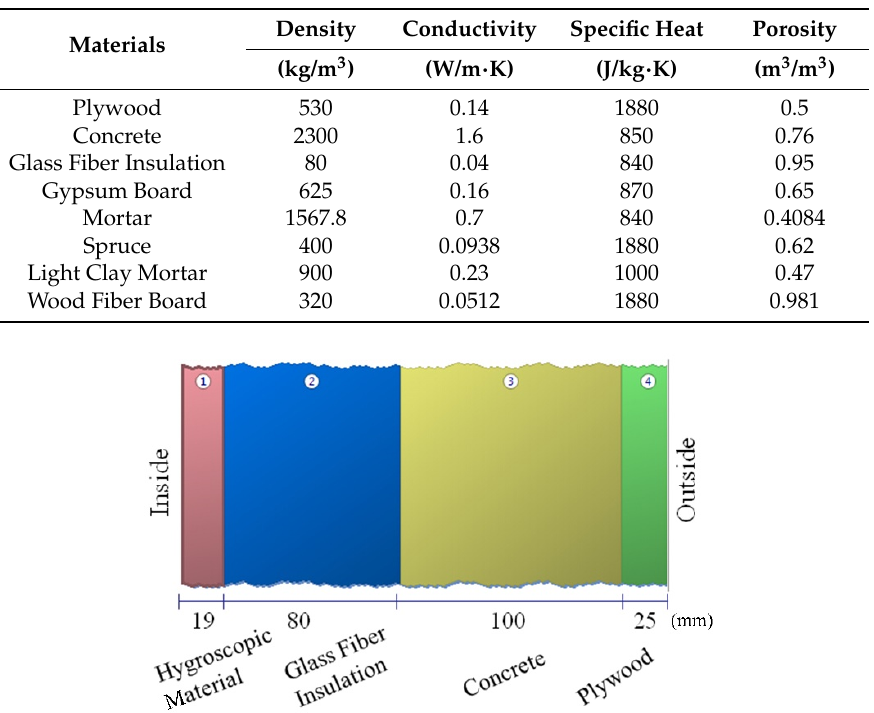
Table 2. Physical properties of the materials.